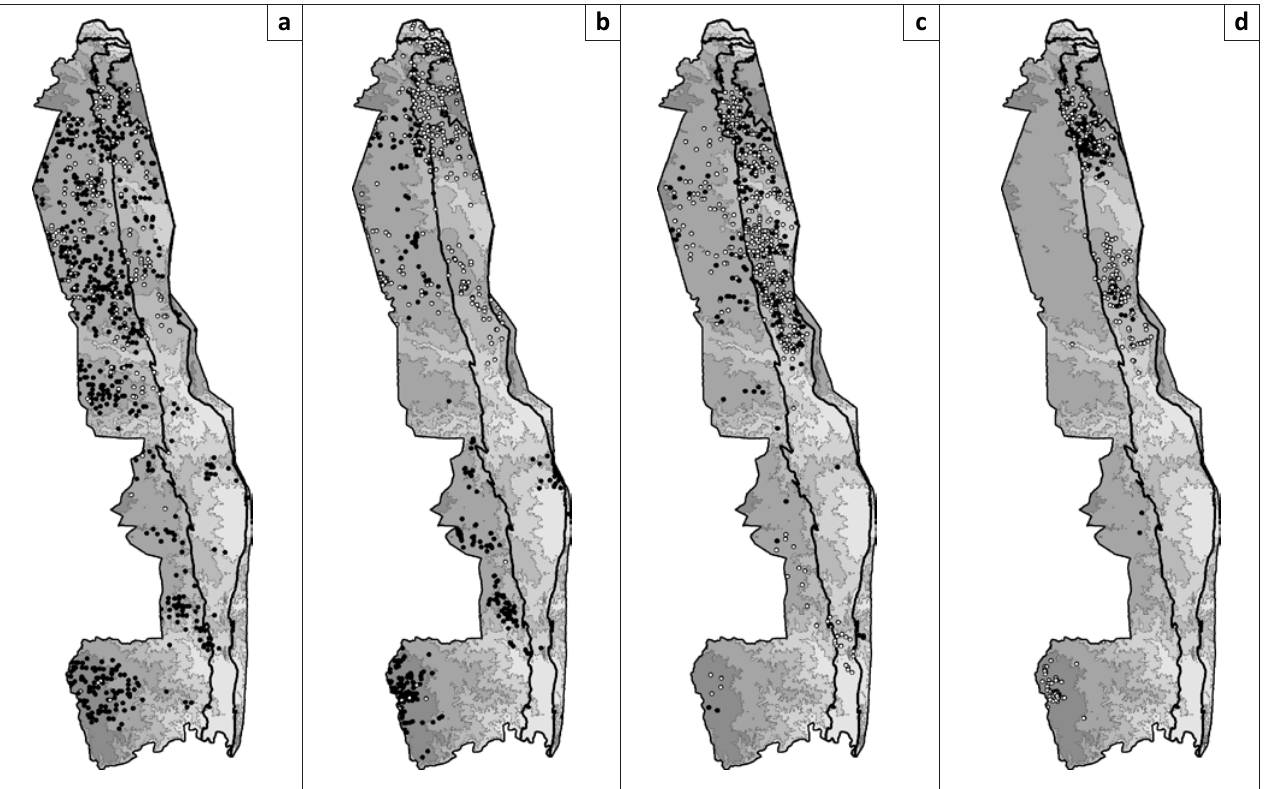
FIGURE 5: Distribution of census observation localities in relation to altitude for sable antelope (black dots) and eland (white dots) during (a) 1980/1986 combined and (b) 2005, and for roan antelope (black dots) and tsessebe (white dots) during (c) 1980/1986 combined and (d)